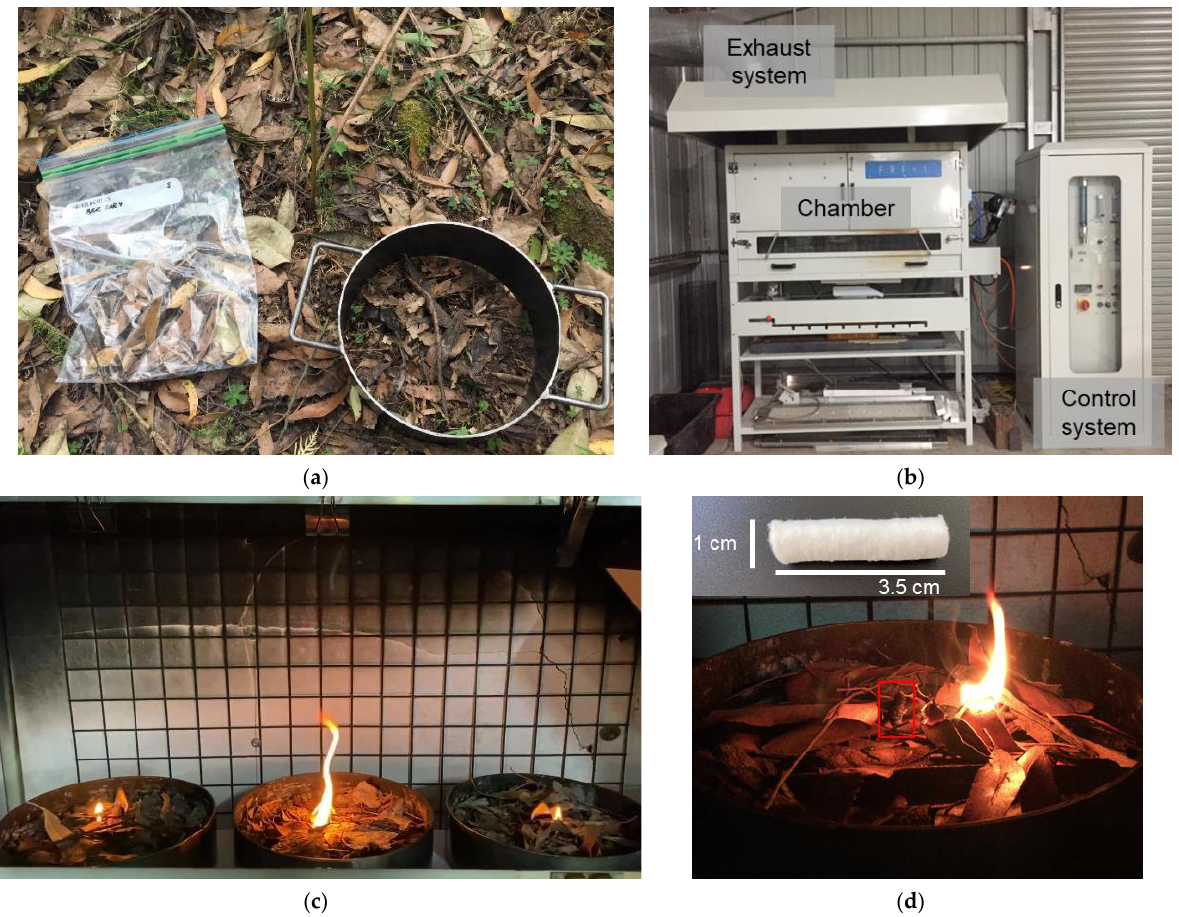
Figure 2. Photos of litter collection and laboratory experiments: ( a ) litter collection using 25 cm diameter metal ring; ( b ) flame propagation apparatus (FPA) showing the exhaust system, chamber and control system; ( c ) inside FPA chamber, where laboratory ignition experiments occurred; ( d ) example of laboratory ignition in the early stage of fire initiation, with cotton cylinder shown in red box. Inset ( d ) shows cotton cylinder firebrand used in laboratory and field experiments. Photos: J. Burton.